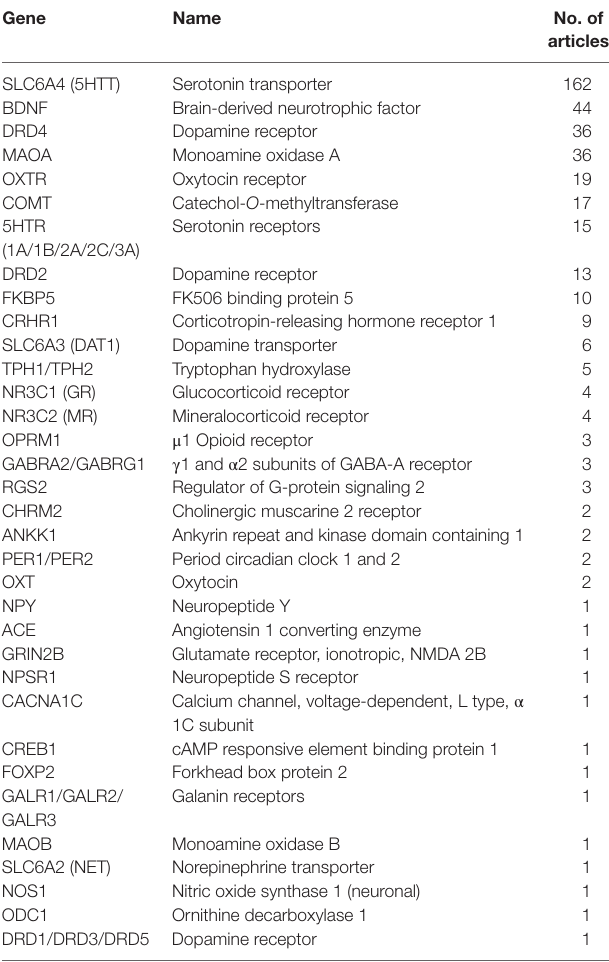
TABLe 1 | Type and number of genes included in gene–environment interactions studies.